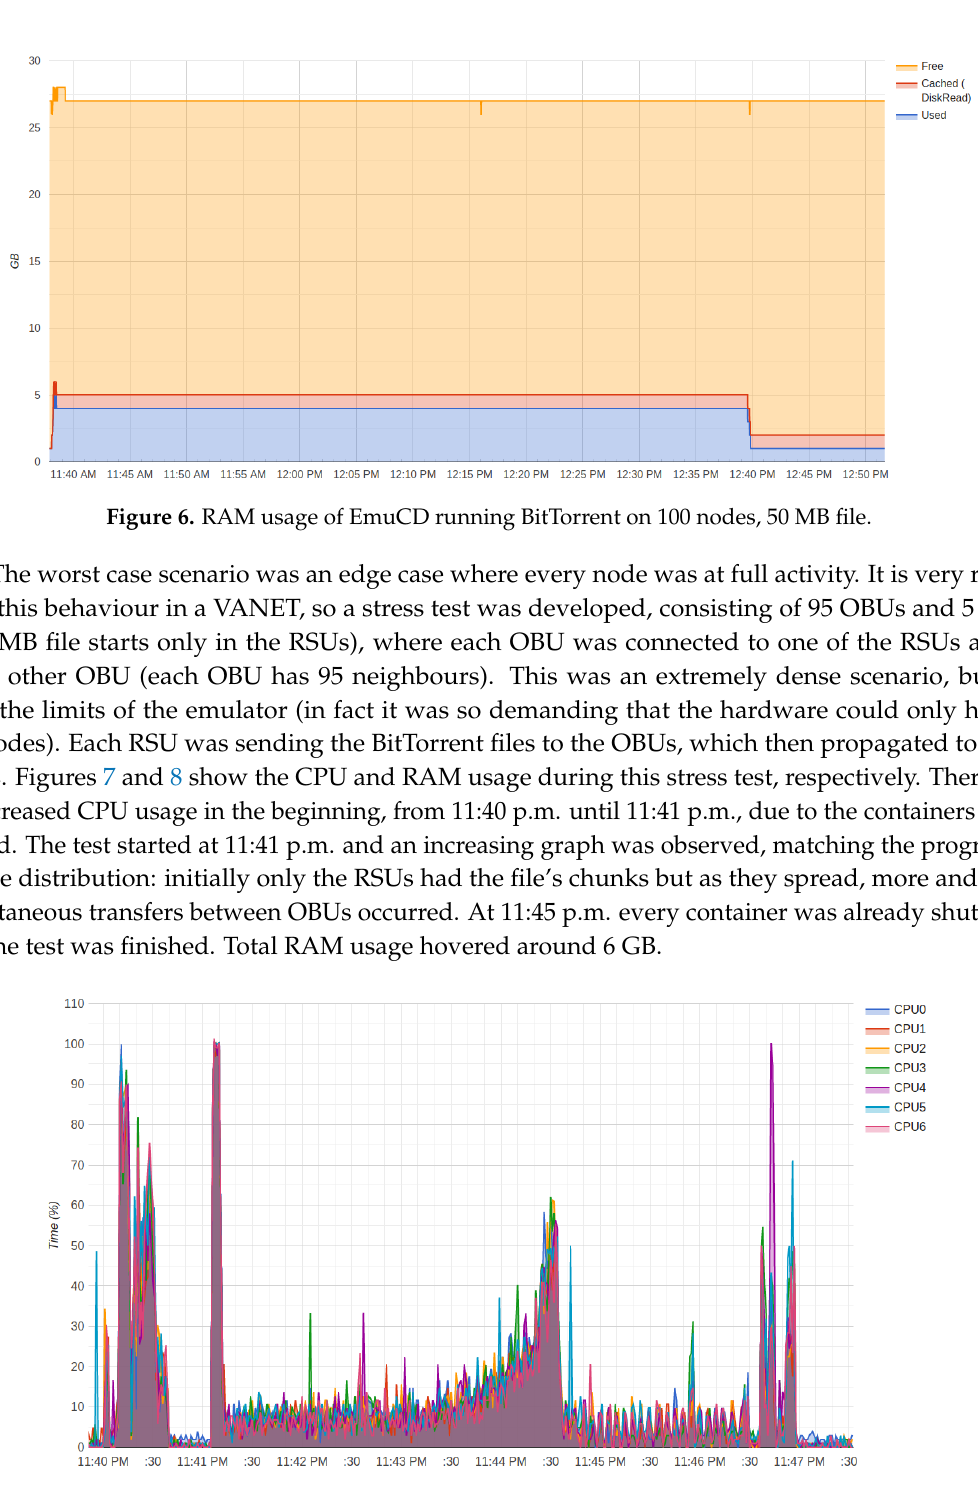
Figure 7. CPU usage of BitTorrent during a stress test, 100 nodes, 50 MB